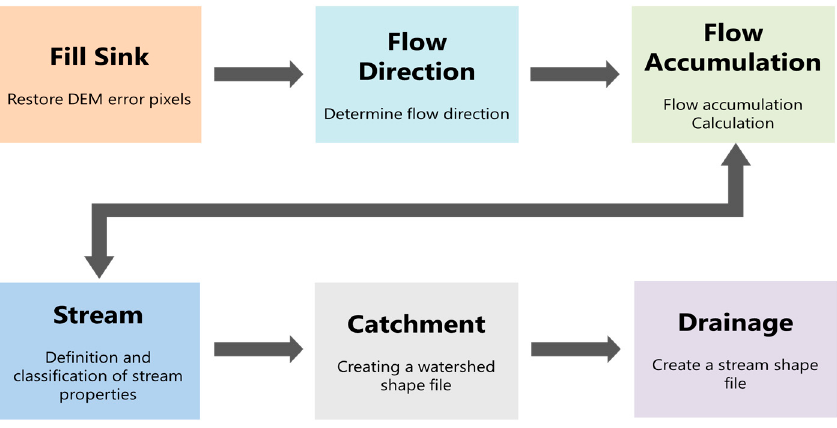
Figure 5. Drainage Tool . Table 2. Parameters of the GRM model.